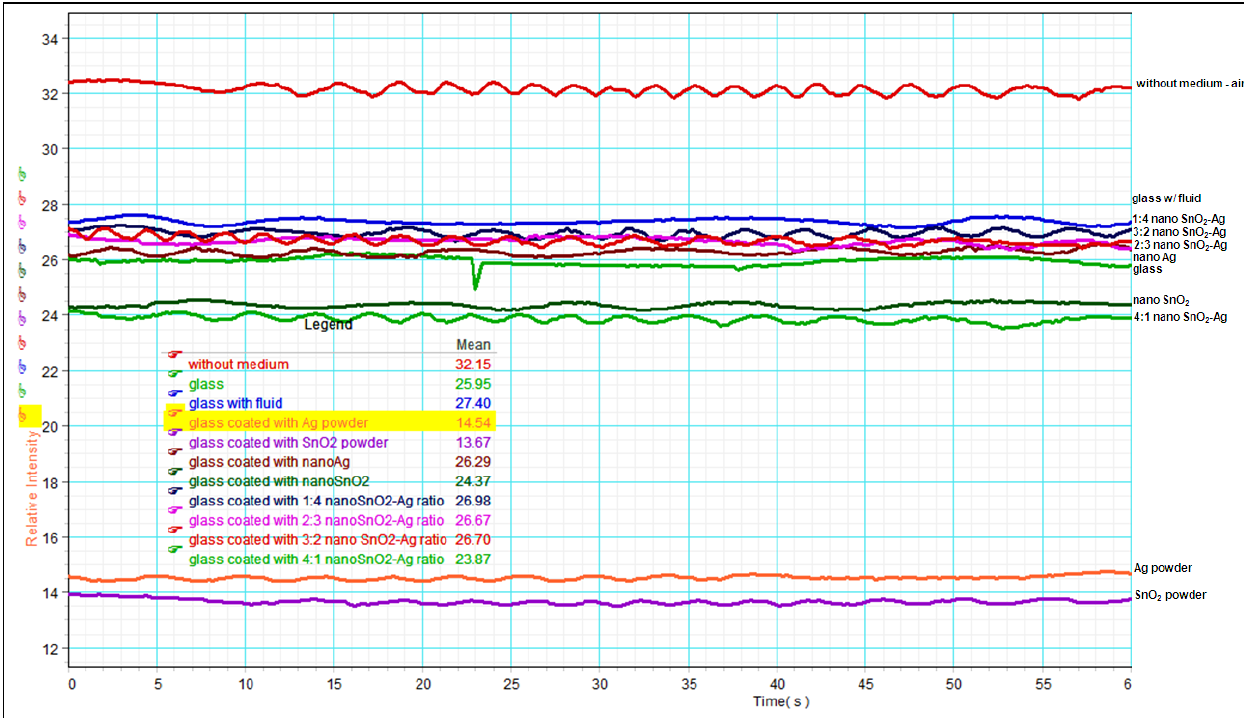
Figure 5. Graph of relative intensity of UVA vs . time graph of tin-oxide, silver, mass ratio of tin oxide silver nanocomposite material, glass slide, and without glass